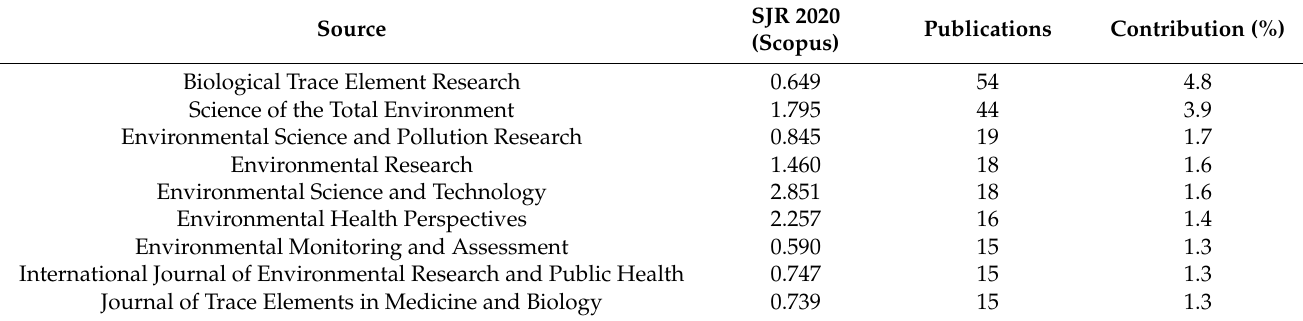
Table 5. The top 8 most popular journals (at least 15